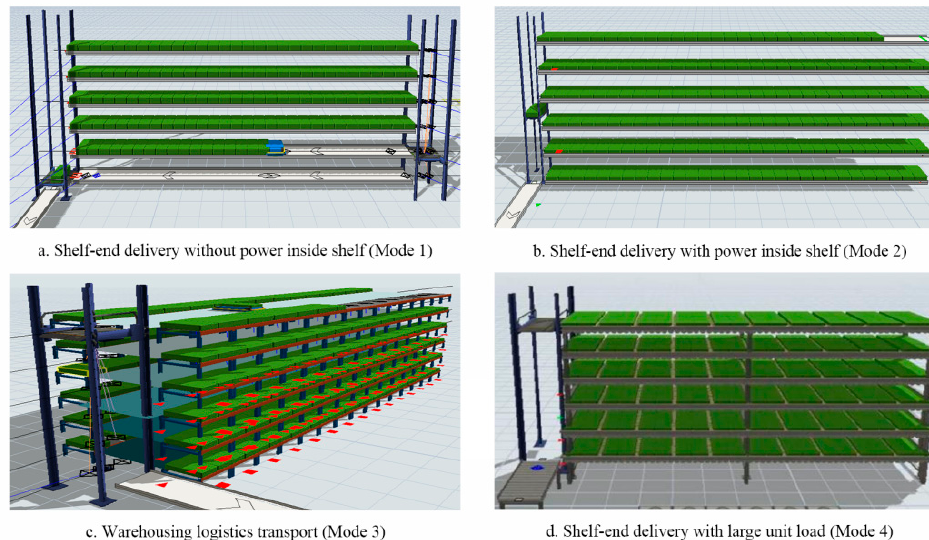
Figure 6. Simulation models of four transport modes. Table 2. Level values of simulation experiment with Flexsim.